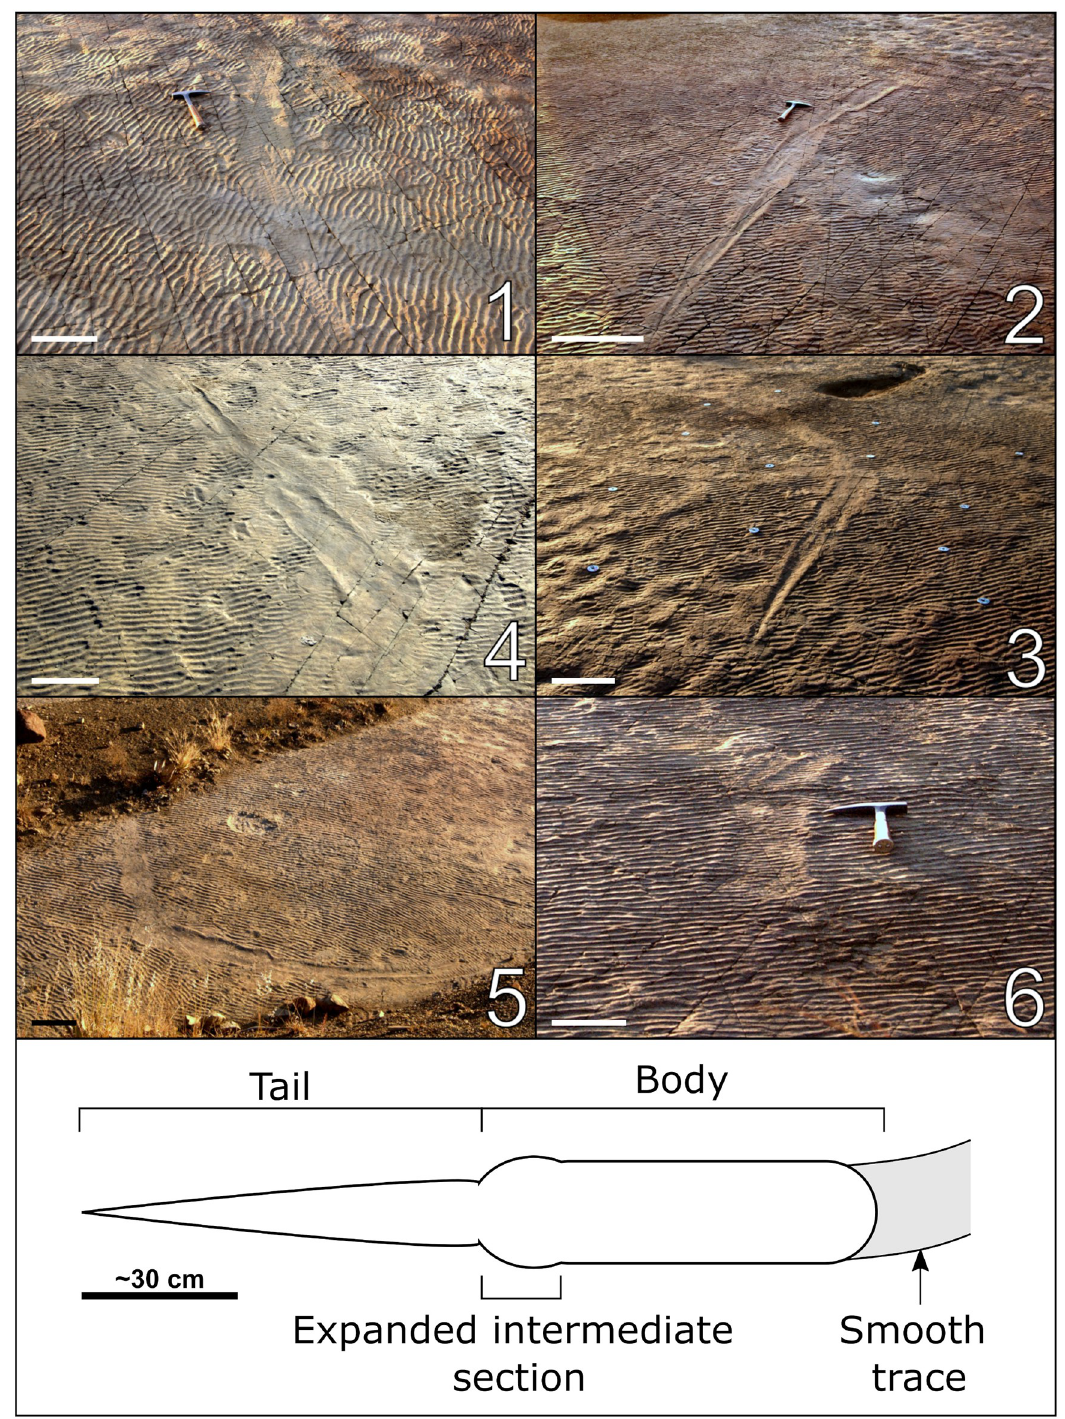
Fig 6. Oblique field photographs of the six best preserved large impressions from the Dave Green palaeosurface and simplified sketch of an impression showing the characteristic “body”, “tail”, and intermediate expanded sections. Numbering of the impressions corresponds with the rest of the figures and text. In parts 1–6: scale bars equal 30 cm.